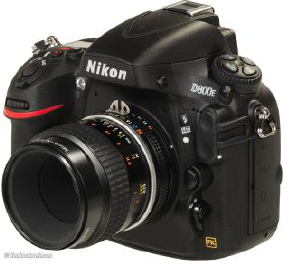
5. used for the classical